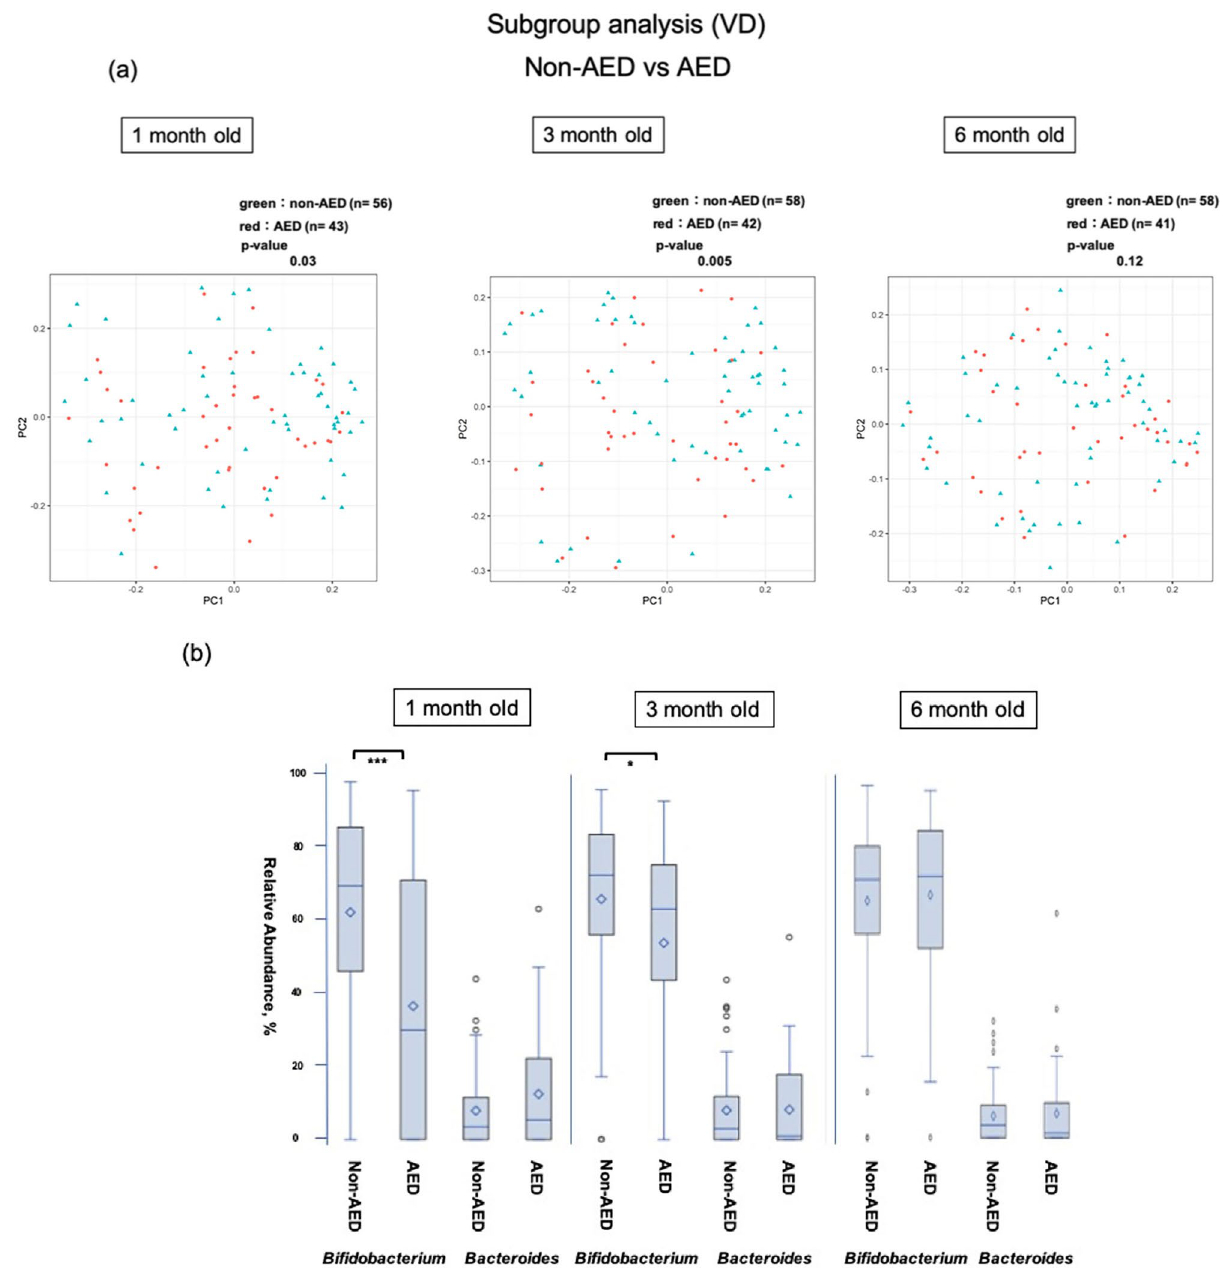
Figure 3. Comparison of the β diversity and occupancy of the top two bacteria species in the AED and non- AED groups of the vaginal delivery group. ( a ) Comparison of β diversity of the intestinal microbiome between infants at each age with (AED) and without (non-AED) antibiotic exposure at vaginal delivery. ( b ) Comparison of Bifidobacteria and Bacteroides occupancies in infants in the AED and non-AED groups with vaginal delivery, shown as box-whisker plots at each age. The AED and non-AED groups included 43 and 56 infants at 1 month (99 in total), 42 and 58 infants at 3 months (100 in total), and 41 and 58 infants at 6 months (99 in total). The significance level was set at 5%. * p < 0.05, *** p < 0.001 using Mann–Whitney U-test. This figure was generated using SAS version 9.4 (https